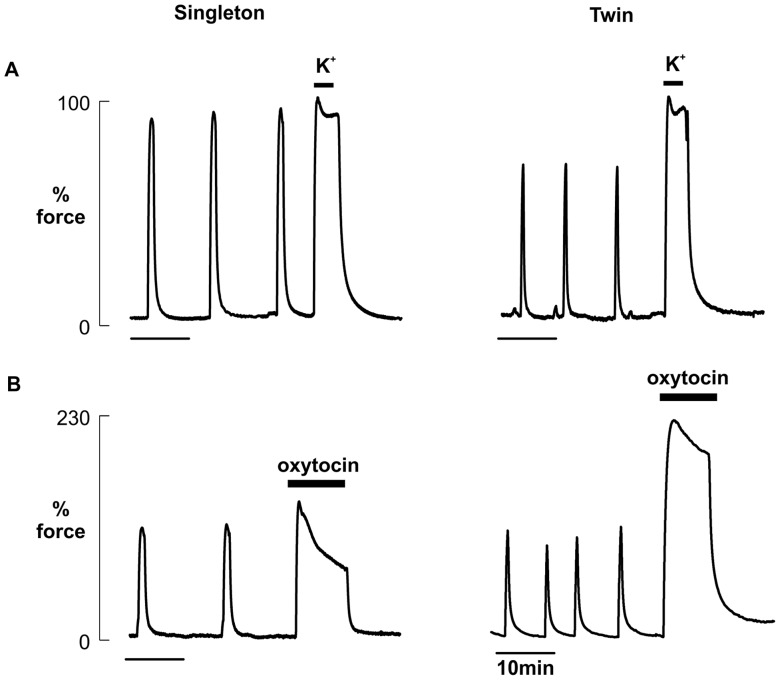
Contractile activity in human myometrium from singleton and twin pregnancy.Representative traces of spontaneous contractile activity of myometrium from singleton and twin pregnancies followed by (A) 2 min application of 40 mM KCl (K+) to depolarise the myometrium and (B) 20 min application of 10 nM oxytocin. In (A) contraction amplitude under high K was assigned 100%. The mean amplitude of control activity was then expressed as a percentage of high K and compared between groups. In (B), response to oxytocin was compared between singleton and twin samples by measuring the percentage increase in force amplitude of contraction under oxytocin where control activity equalled 100%.